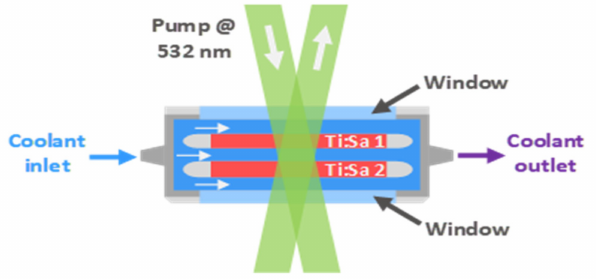
Figure 7. Schema of a double-crystal amplifier head utilizing a transmission-based optical scheme for both pump and seed pulses.